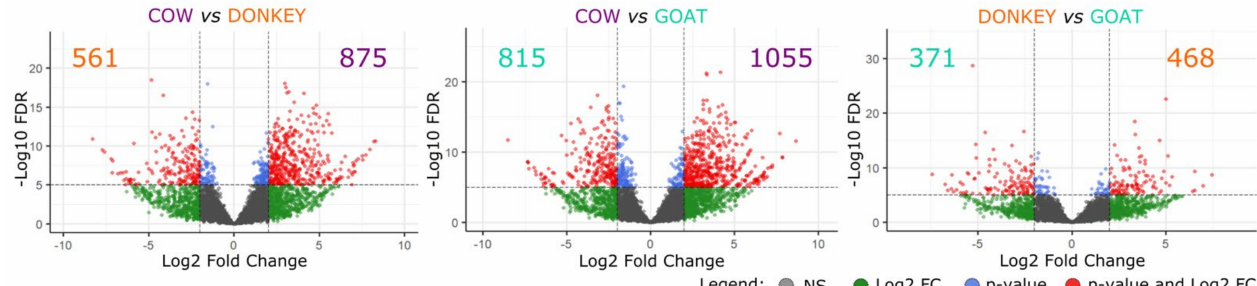
Figure 3. Volcano plots of differentially expressed genes through mEV RNA pairwise comparisons of the three species using DESeq2 for data analysis. The X-axis represents log 2 fold change (log 2 FC) of the pairwise comparison, while the Y-axis indicates significance of differential expression (False Discovery Rate - FDR). The gray dots indicate no significant (NS) changes in the gene expression (|log 2 FC| < 2, FDR > 0.05), the green dots denote genes with |log 2 FC| > 2 but not significant (FDR > 0.05), light blue dots indicate very small changes in gene expression (|log 2 FC| < 2), while red dots represent significantly up- and down-regulated genes (|log 2 FC| > 2, FDR < 0.05). Purple numbers indicate the significantly up-regulated genes in cow compared to the other reported species, the orange numbers indicate those up-regulated in donkey, and the teal numbers refer to goat over-expressed